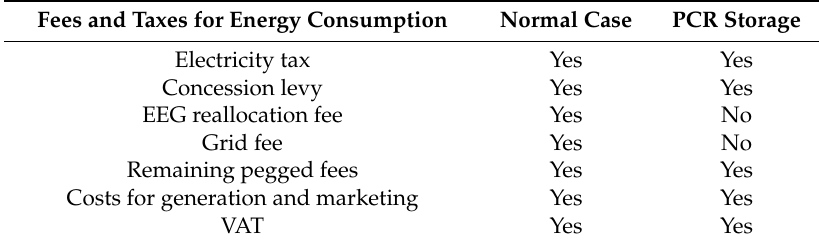
Table 1. Comparison of electricity overhead fees effective in Germany for end consumers and PCR usage, respectively. EEG: Renewable Energy Act; and VAT: value-added